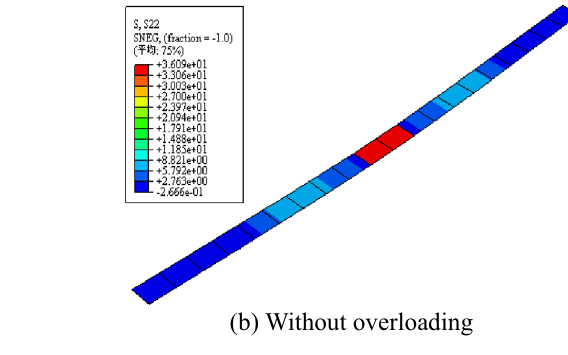
Figure 14. Stress comparison of CFRP sheet with or without